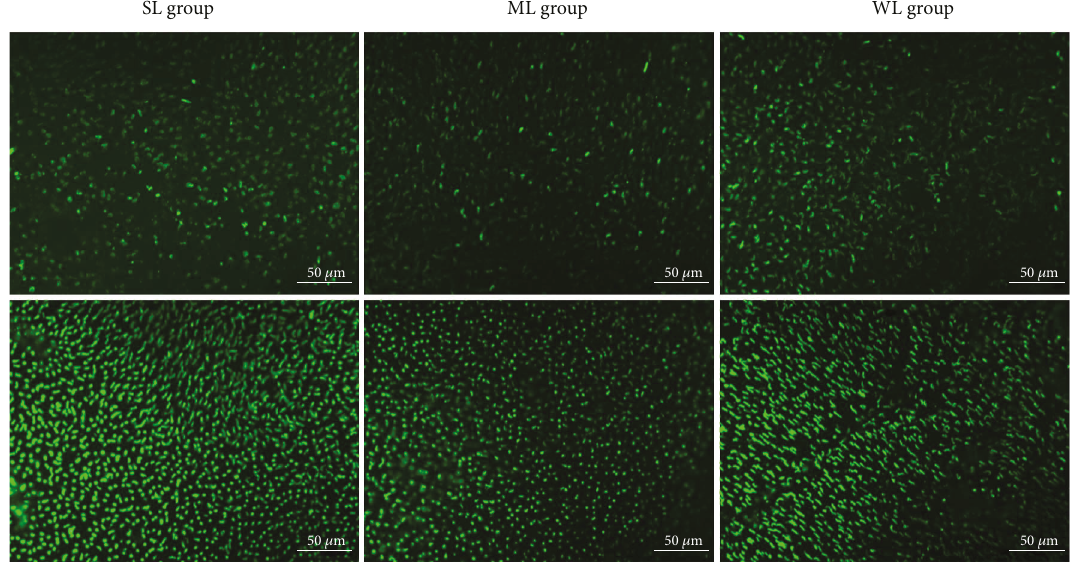
Figure 2: S-cones changed in di ff erent areas in the three groups. Top: dorsal retina; bottom: ventral retina. SL: short-wavelength light; ML: middle-wavelength light; WL: white light. Scale bar =50 μ